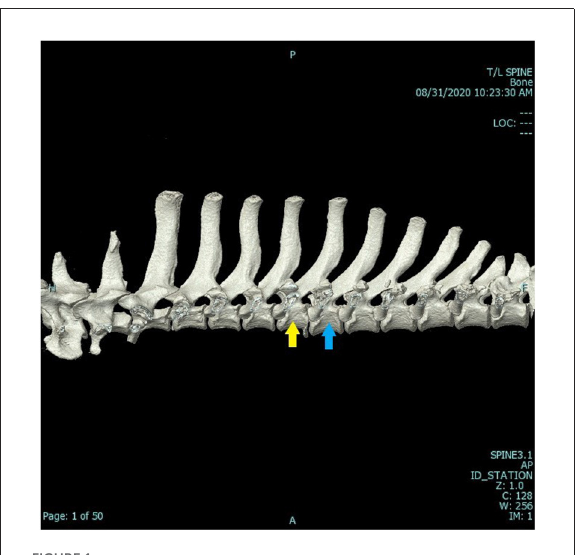
FIGURE1 Computed tomographic (CT) 3-D reconstruction of the patient’s spine with no traction applied. The yellow arrow indicates T5, and the blue arrow indicates T6. This image was taken preoperatively, and the patient was under general anesthesia.